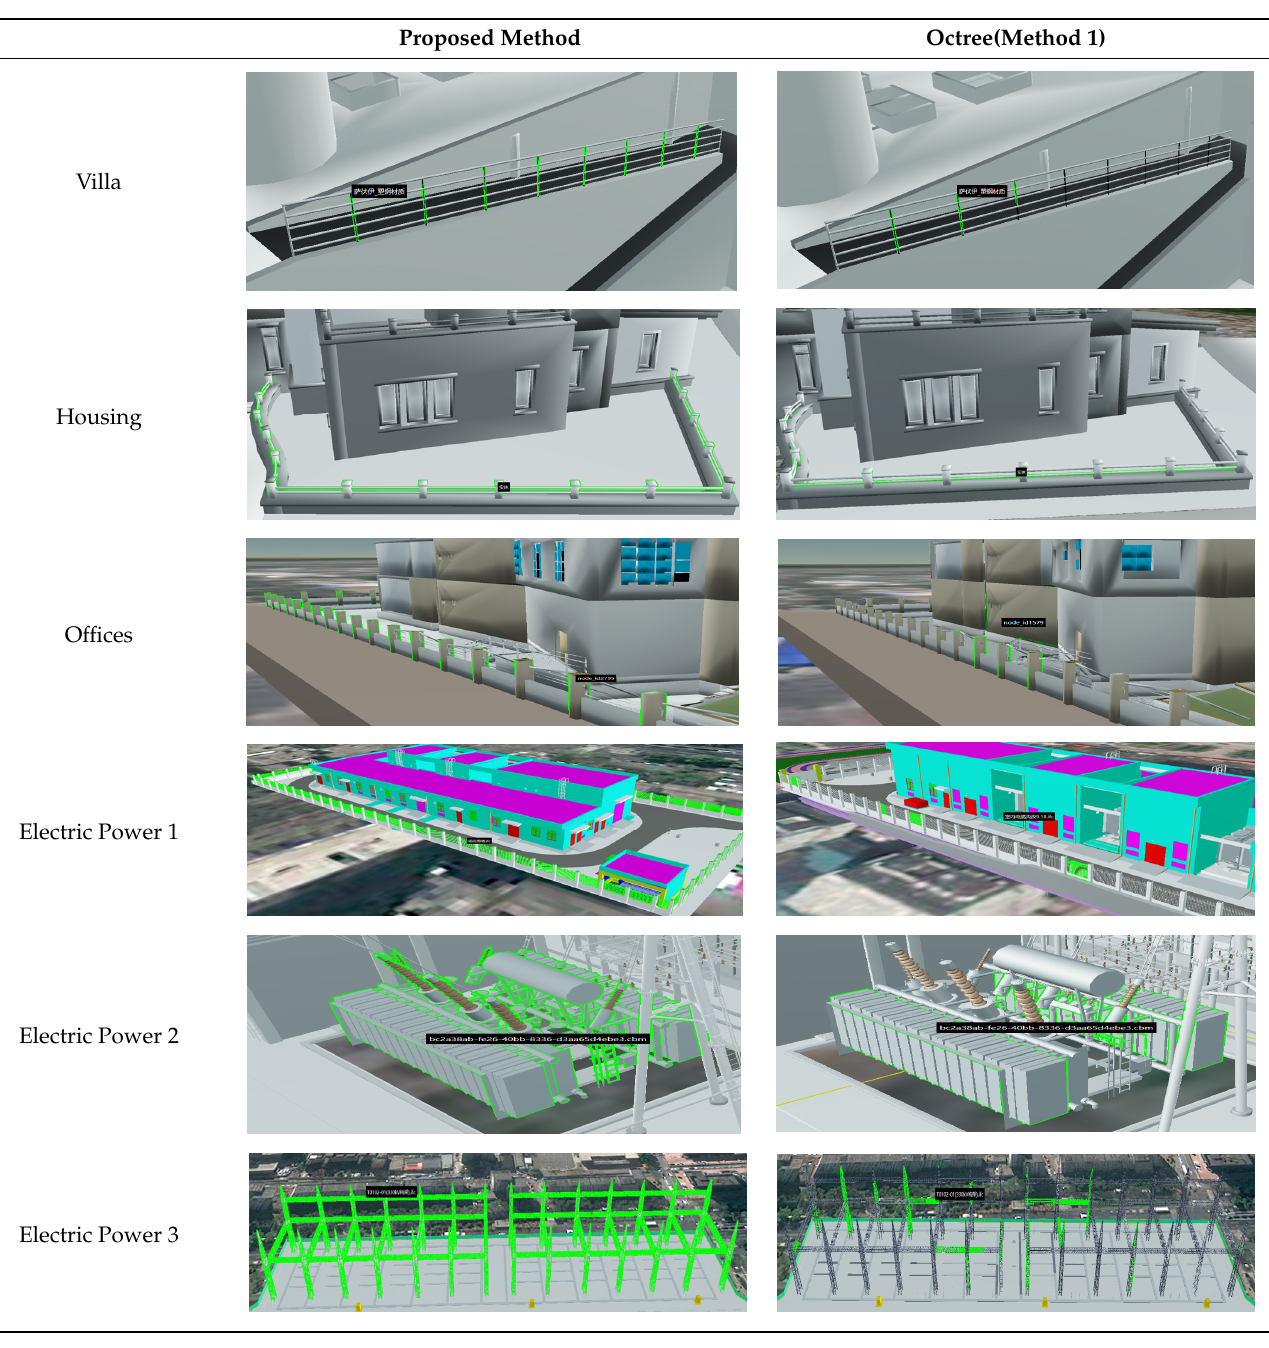
Table 2. Effects of picking and querying.